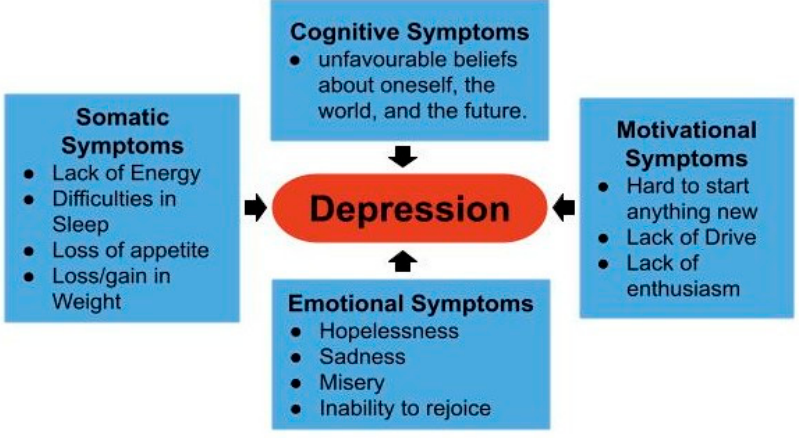
Figure 1. Various facets of MDD [14–18]. Prevalence: An estimated 3.8% of the world’s population suffers from depression. This number rises to 5.0% among adults and 5.7% among individuals aged 60 and older [19,20]. About 280 million people worldwide suffer from depression. Table 1 identifies the five most depressed countries in the world as of 2022, adjusted by the World Health Organization (WHO) as per population